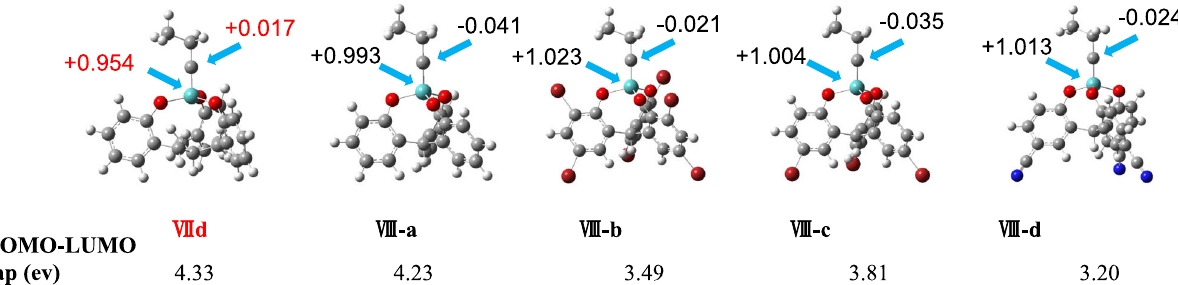
Fig. 6 Catalyst structure modeling. Energy minimized structures of the catalytically active species ( VIId , VIII-a , VIII-b , VIII-c , and VIII-d ) were optimized at the B3LYP level of density functional theory. The energy gap (HOMO-LUMO gap) between the LUMO energy level of the catalyst and HOMO energy level of the model substrate 1-chloro-4-propynylbenzene was calculated for each catalyst. The Mulliken charge values of the Mo and carbyne carbon (pointed by blue arrows) of each catalyst are reaction and the white precipitate was collected by fi ltration. The crude product (7.68 g, 73%) was used for the next step without further puri fi cation. Synthesis of compound 2 . The literature procedure was followed with some modi fi cation 47 . To a solution of compound tris(2-methoxyphenyl)methanol (3.51 g, 10.0 mmol) in acetonitrile (20 mL) and THF (30 mL) was added TsOH·H 2 O (2.10 g, 11.0 mmol) at 0°C. After stirring at room temperature for 12 h, H 2 O (200mL) was added. The solution was extracted with Et 2 O (3× 50mL). The combined organic layer was dried (Na 2 SO 4 ) and concentrated to give the com- pound 2 as a yellow solid (3.07 g, 92%).